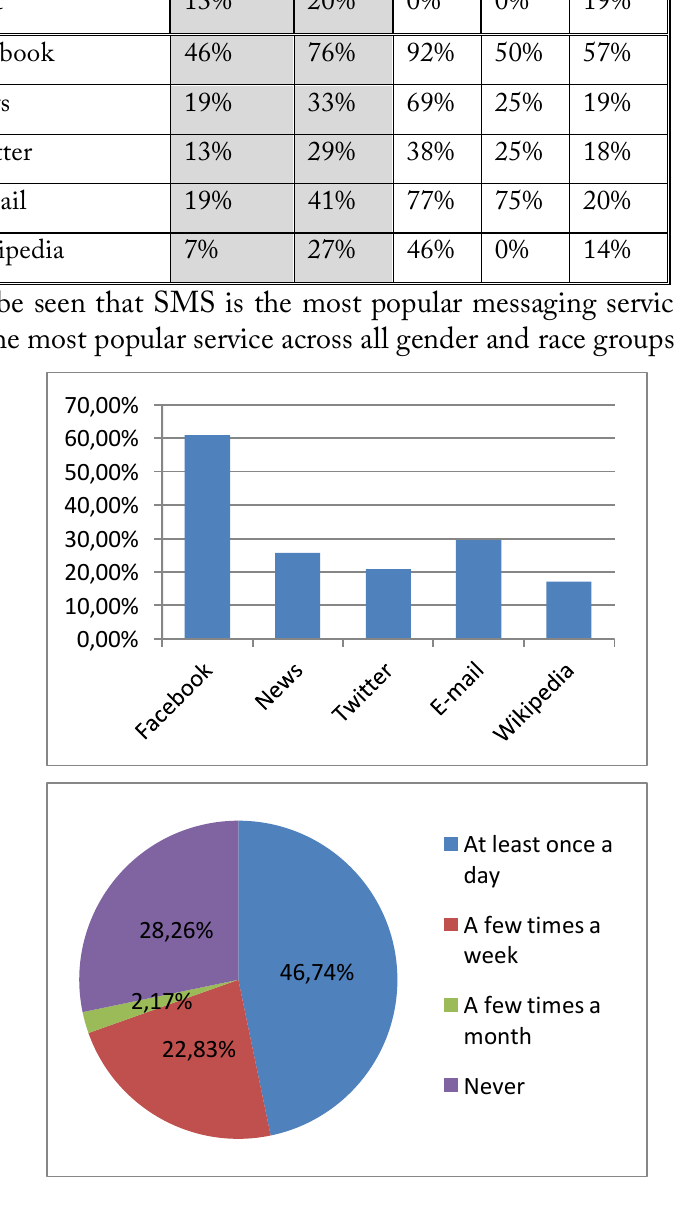
Figure 3: (a) Data services accessed by respondents; (b) Frequency of accessing online data